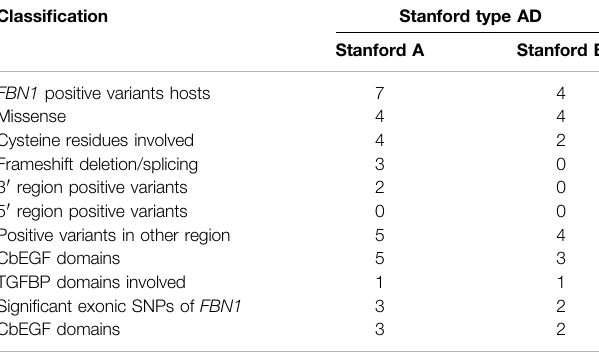
TABLE 5 | Speci fi c positive variants and SNPs information of FBN1 between Stanford A and Stanford B